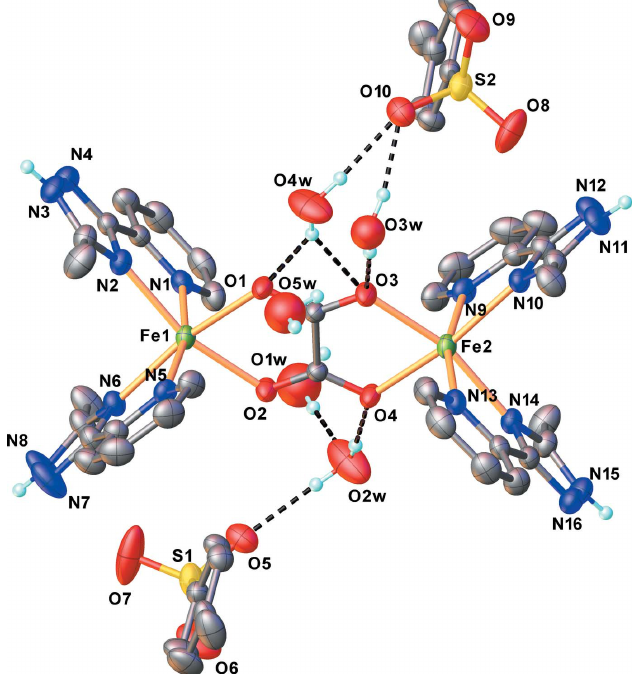
Figure 1 X-ray molecular structure of the title compound with selected atom labels and displacement ellipsoids drawn at the 50% level. Some H atoms are omitted for clarity. Key: carbon, grey; nitrogen, blue; oxygen, red; sulfur, yellow; iron, light